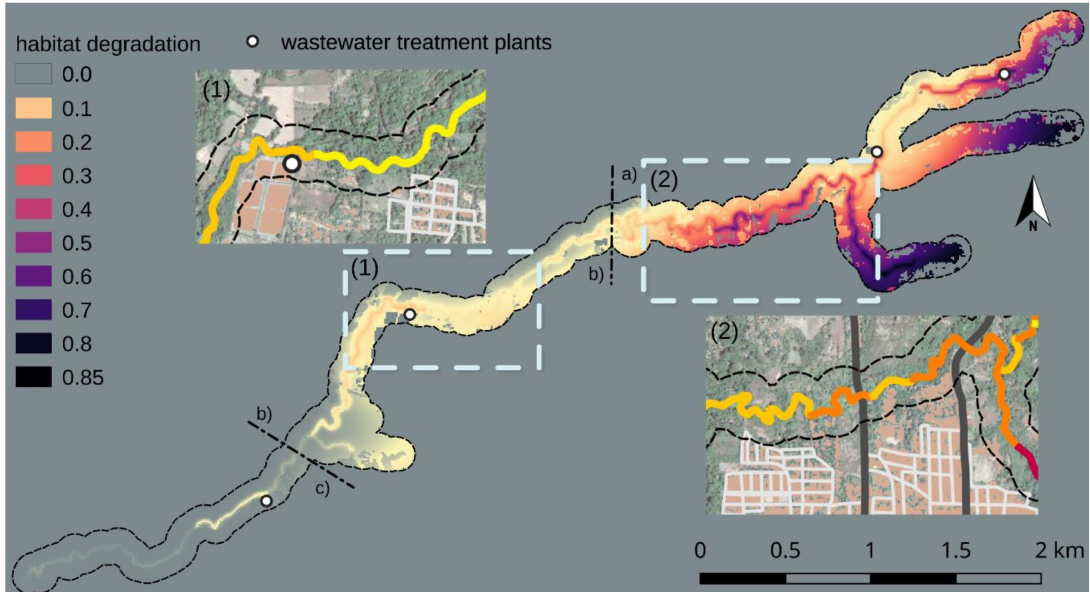
Figure 7. Habitat degradation as a result of the combination of all threats in the study area. Rectangles and the respective satellite images show areas that are discussed in more detail in the text: (1) residential areas invading into the river and (2) wastewater treatment plant (satellite images obtained from Google Earth Pro). The grey shade is used as a background to provide a better illustration. ( a ) Very high, ( b ) moderate, and ( c ) very low habitat degradation